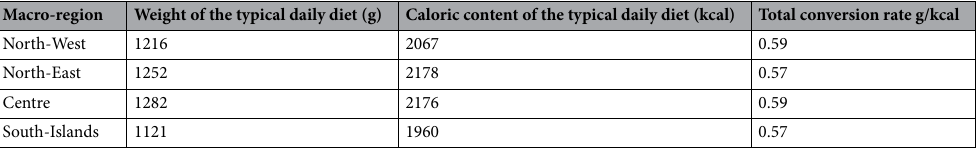
Table 1. Caloric content of the typical Italian diet by macro-region. The table reports the weight of the typical diet expressed in grams per day, its caloric content expressed in kcal, and the conversion rate obtained by dividing the weight of the daily diet by its respective caloric content, expressed in grams per kcal. For each area, a conversion rate, expressed in grams of food for each kcal, is calculated as the ration between the two. This conversion rate supports the conversion of kcal into quantities of